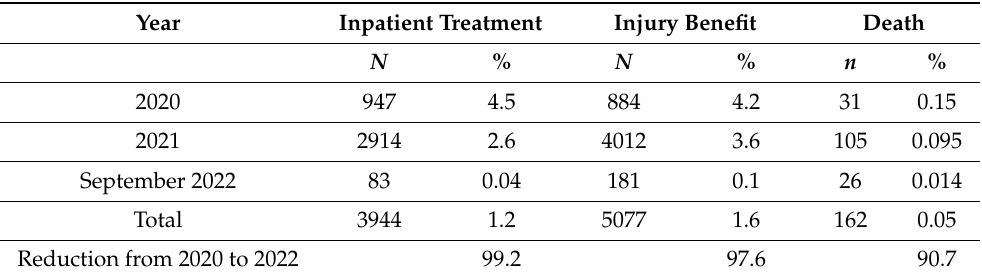
Table 2. Number and proportion of cases with inpatient treatment, receipt of injury benefit, or deaths due to COVID-19 among insured individuals of the BGW with a notifiable occupational